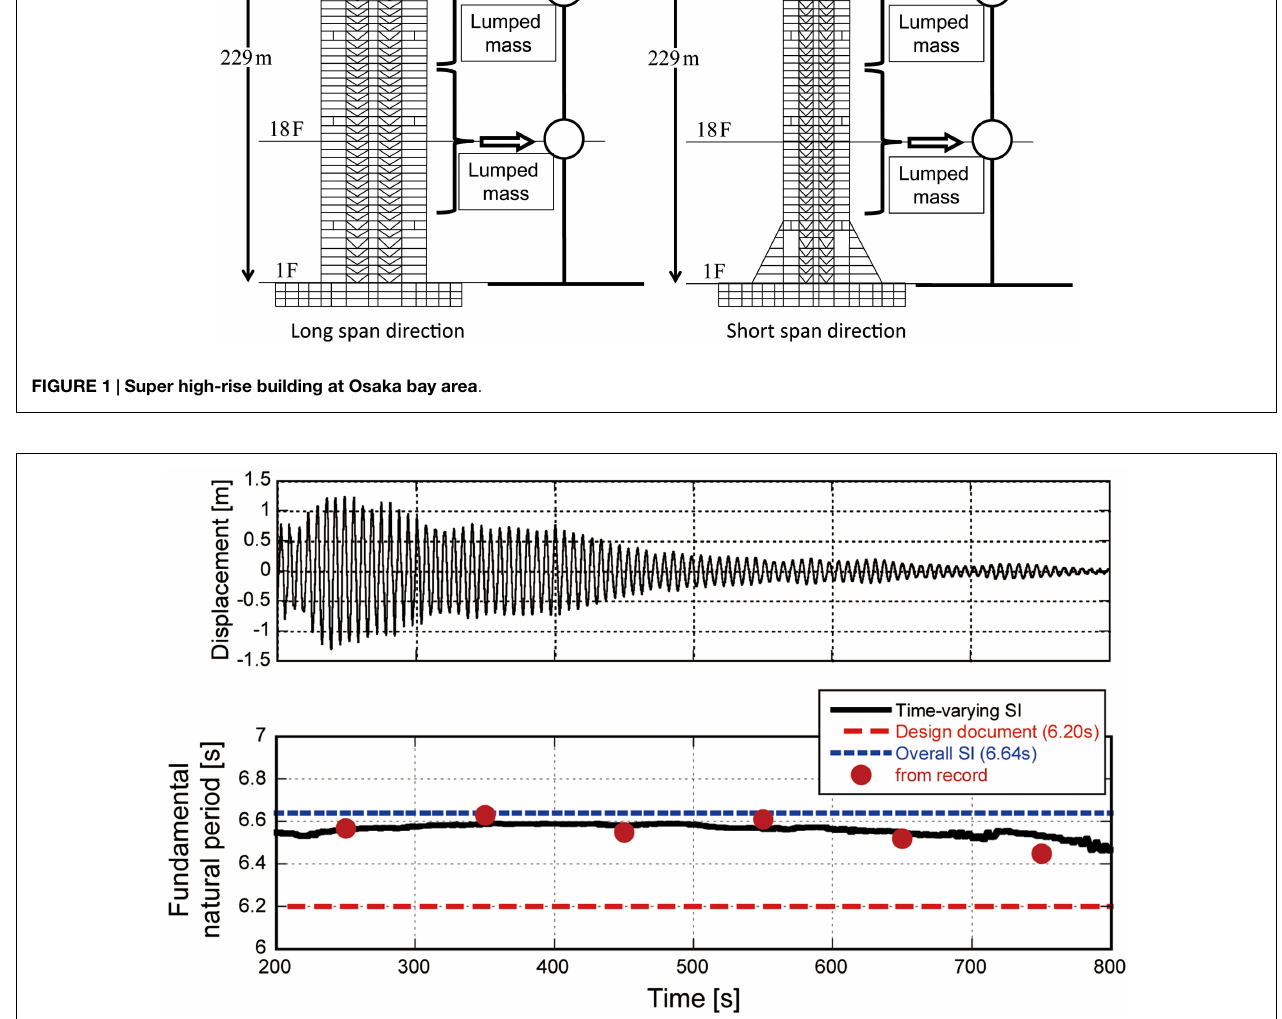
FIGURE 2 | Top-story displacement and fundamental natural period of super high-rise building at Osaka bay area (short-span direction): accuracy investigation through comparison with data from records